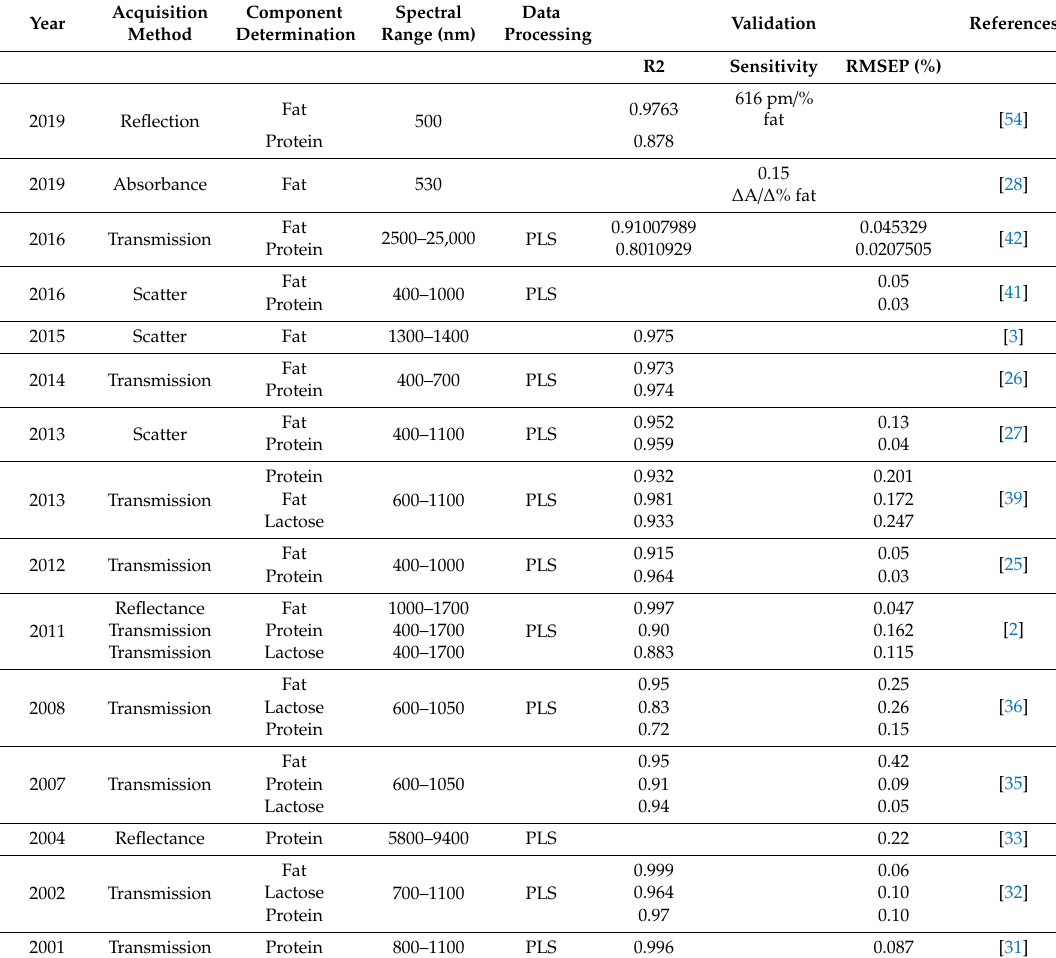
Table 1. Principal methods to estimate main components in milk based on optical